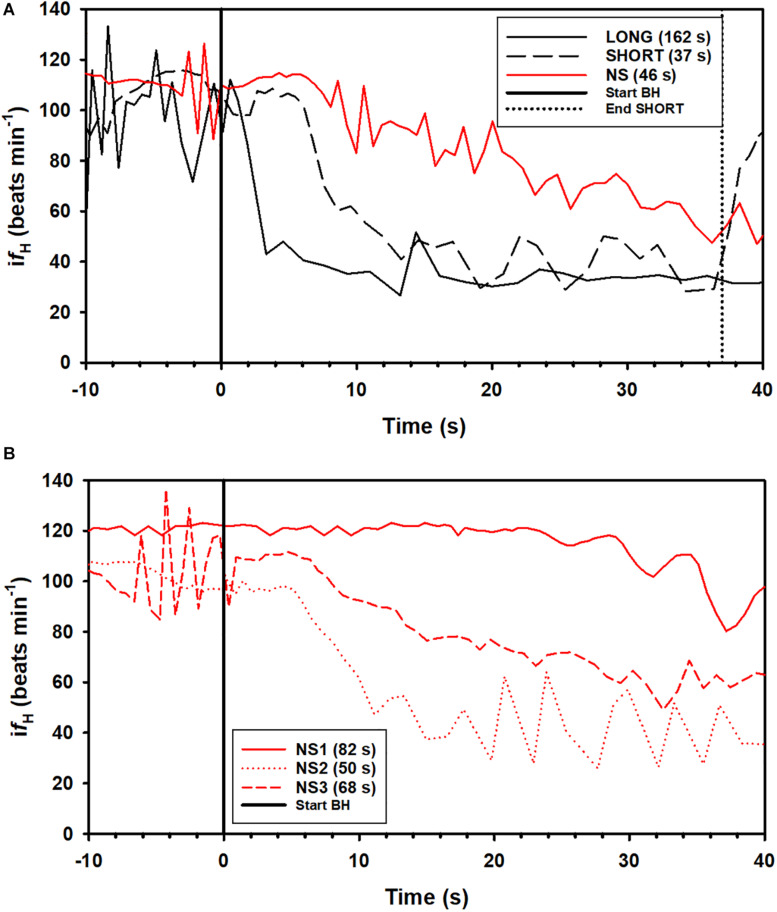
Examples of instantaneous heart rate (ifH) responses from individual dolphins against time before (time –20 to 0) and up to 40 s (time 0 to 40 s) during a breath-hold. (A) ifH for a LONG and SHORT dive (each preceded by a symbol with a pre-determined dive duration), and a dive without a symbol (NS), where dive duration was determined by the dolphin. (B) ifH variation during a breath-hold for 3 NS dives in dolphin D3 (Table 1). The dive durations, the time from the last breath before and first breath after a breath-hold is indicated in parenthesis.